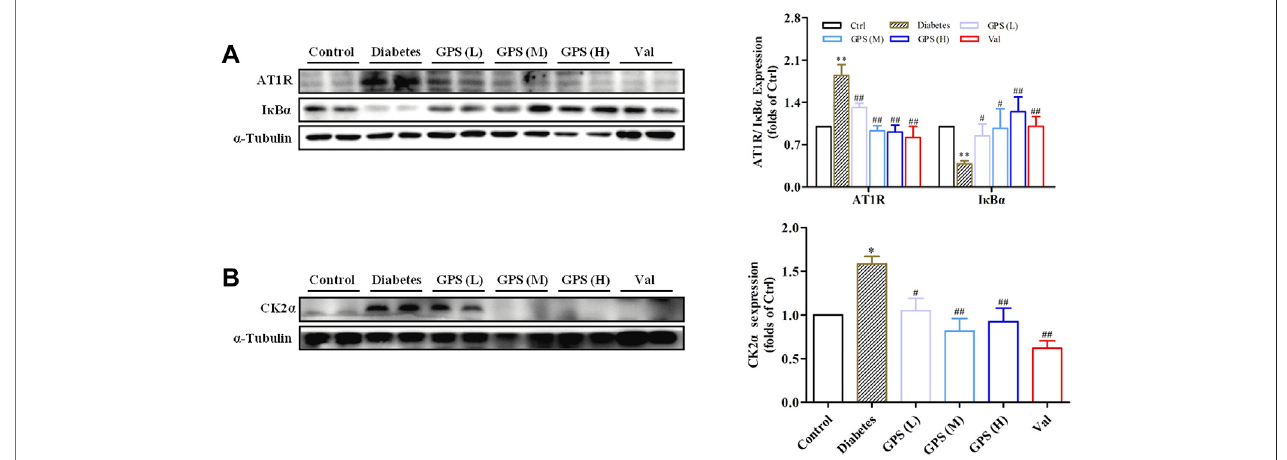
FIGURE 3 | GPS inhibited the AT1R/CK2/NF- κ B pathway in the kidney tissues of diabetic mice. (A,B) Protein levels of AT1R, I κ B α , and CK2 α in renal tissues of diabetic mice were detected by Western blot. Data were expressed as mean ± SD. n = 8. ** p < 0.01 vs . Ctrl. ## p < 0.01 and # p < 0.05 vs . diabetes.